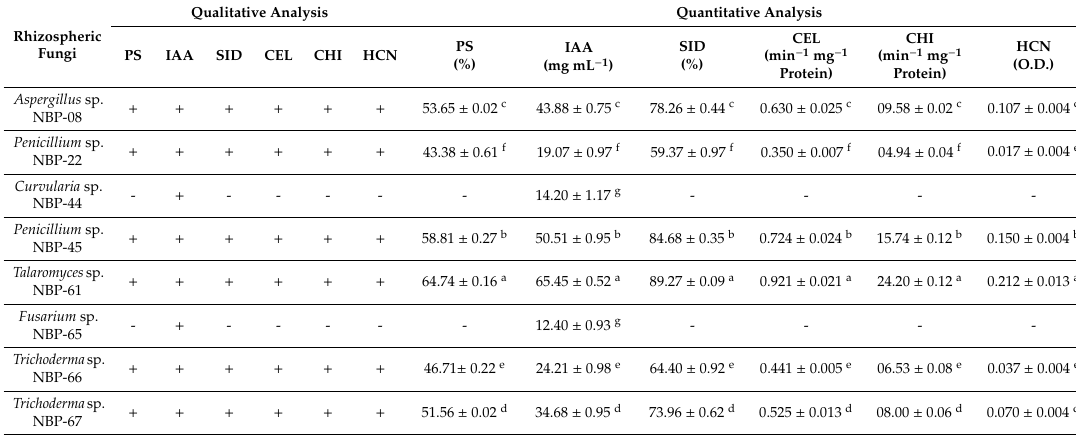
Table 2. Qualitative and quantitative analysis for plant growth-promoting (PGP) properties of antagonistic rhizosphere